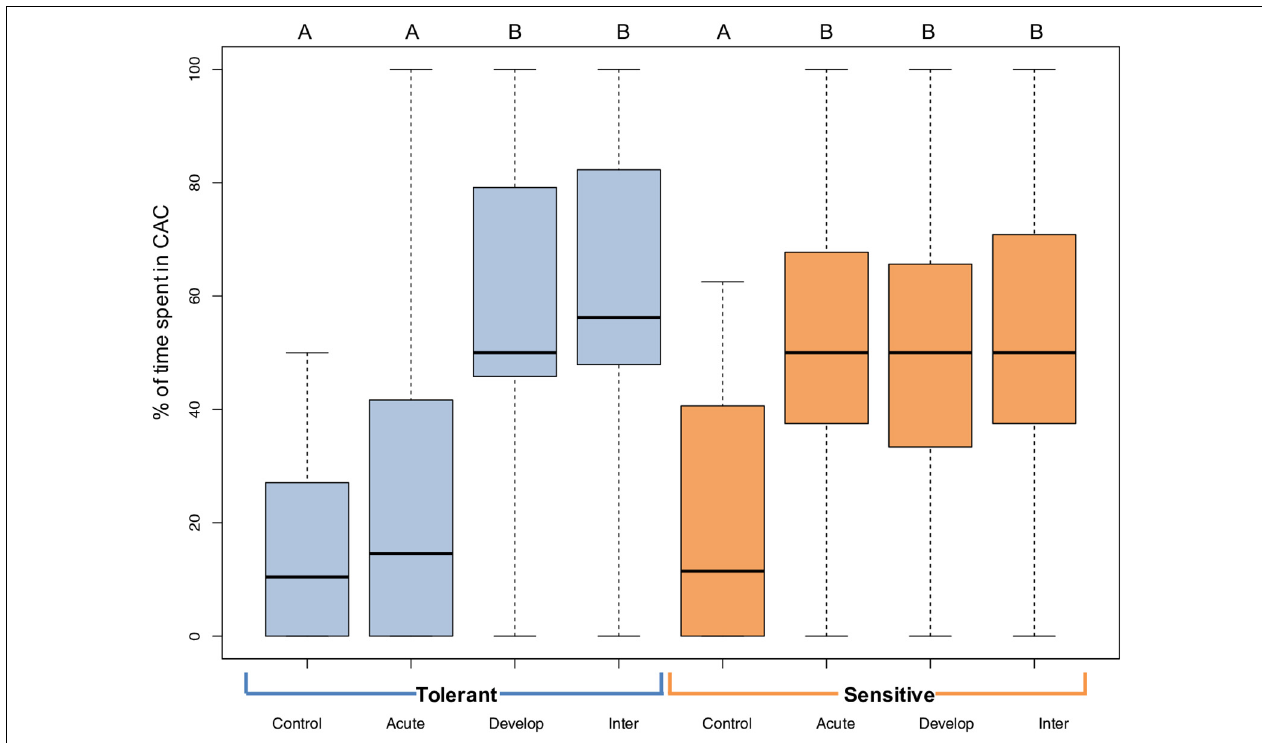
FIGURE 2 | Behavioral responses to chemical alarm cues (CAC) of 5-week-old juvenile A. polyacanthus exposed to different CO 2 treatments. Offspring of tolerant parental phenotype are in blue and sensitive in orange. Control, Acute, Develop, and Inter are the four different environmental CO 2 exposures. The thick black line represents the median, the lower line of the colored box is the first quartile and the top line of the box represents the third quartile; whiskers show minimum and maximum values. Different letters represent significant differences between treatments (Tukey, P < 0.05). N = 15–20 for each of the eight treatments - phenotypes